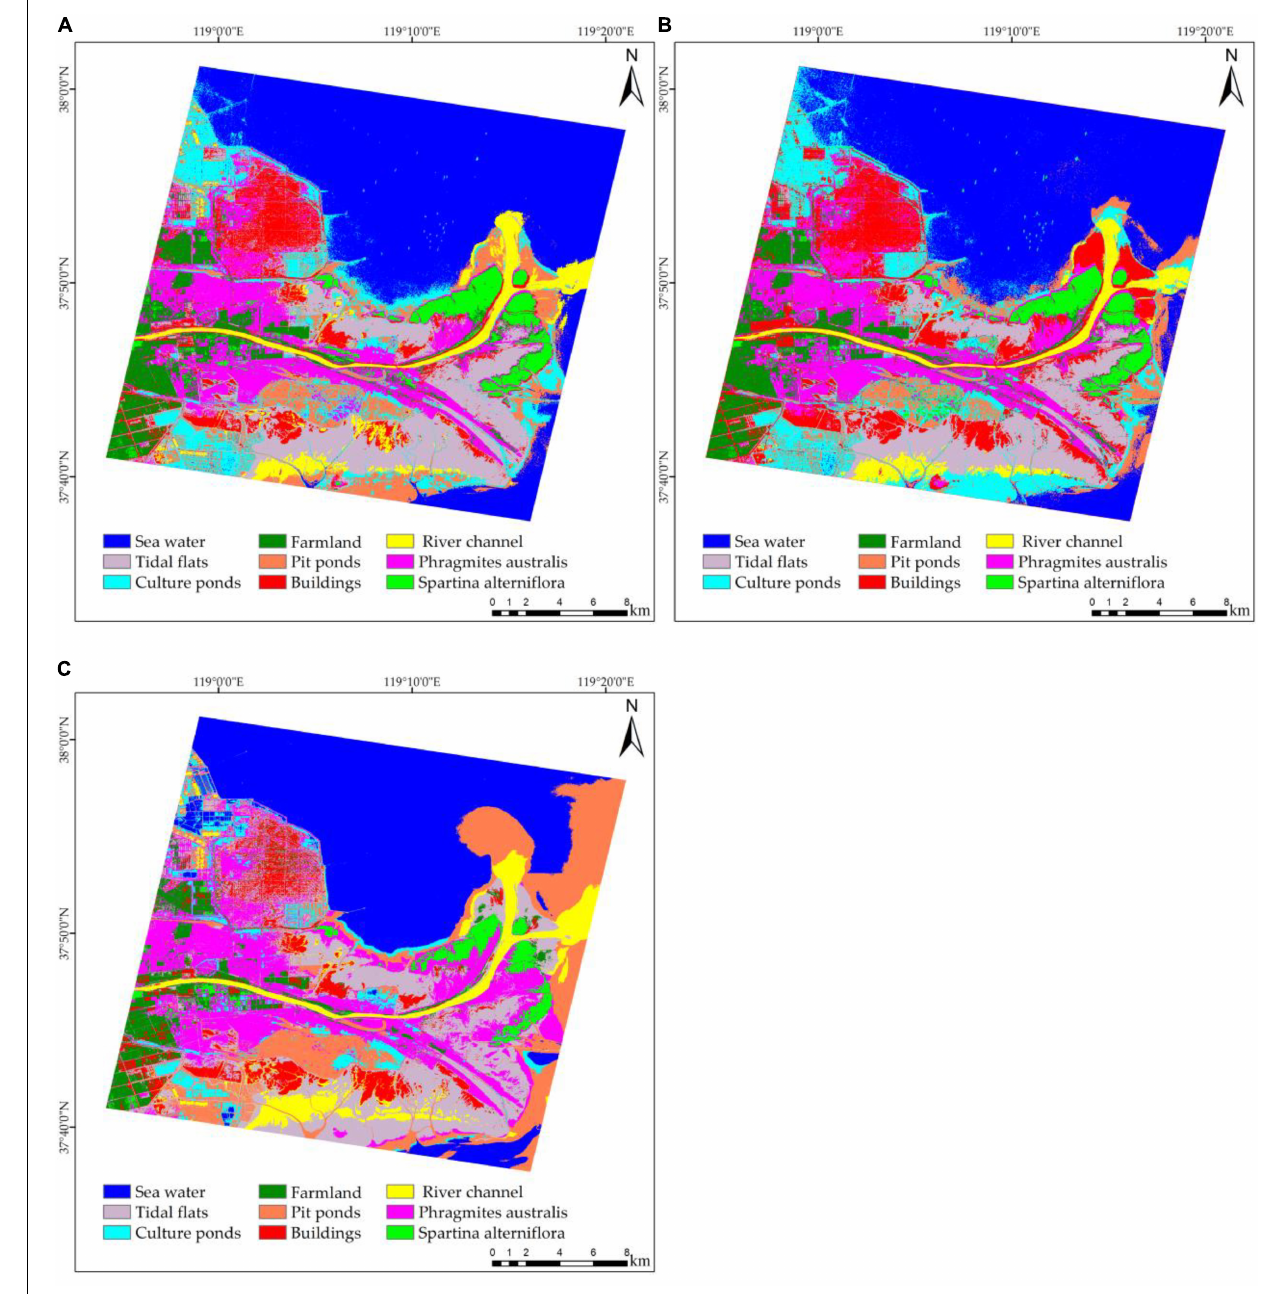
and VAR can better distinguish the types of wetland